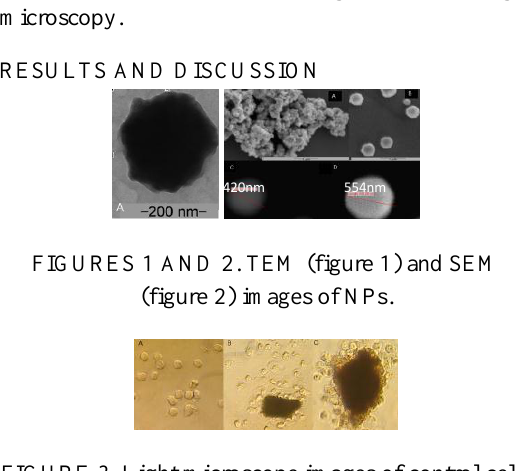
FIGURE 3. Light microscope images of control cells (A), and cells incubated with NPs (B and